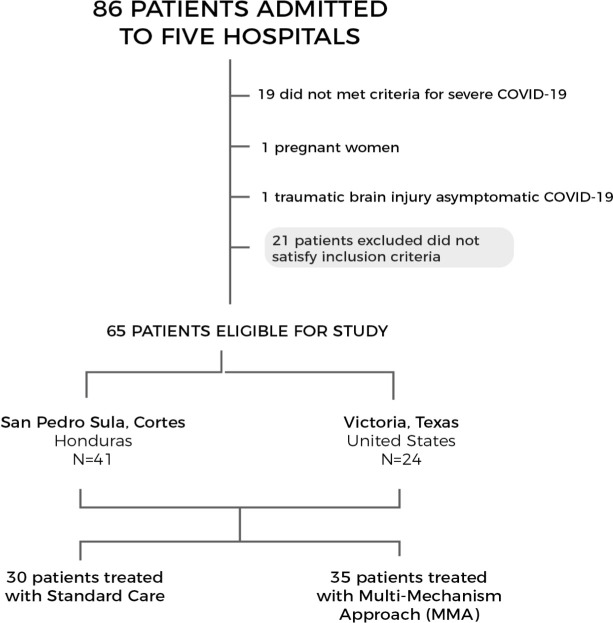
Overview of participants includes in the MMA cohort.